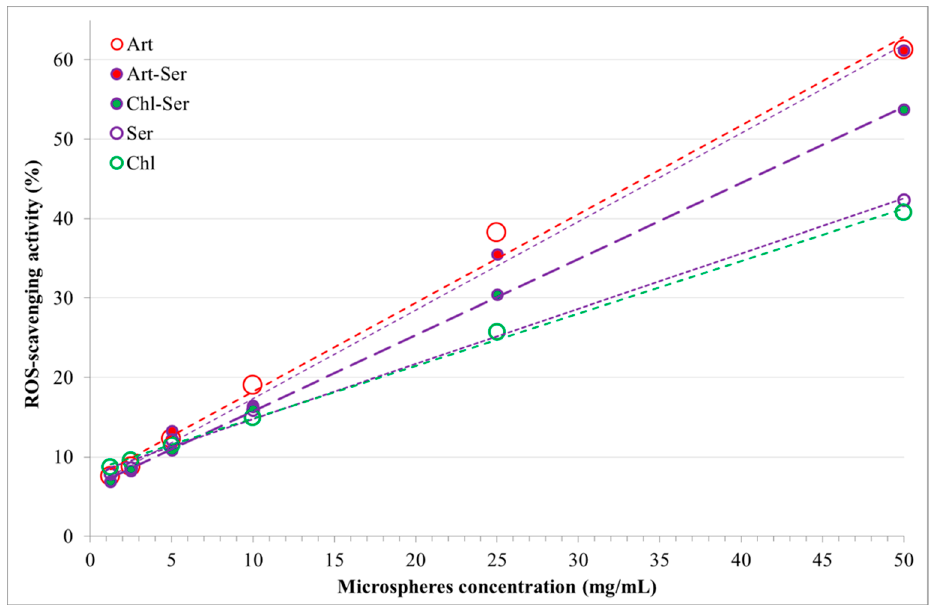
Figure 3. Reactive Oxygen Species (ROS)-scavenging activity (%) and microsphere concentrations (mg/mL) for the formulations studied.